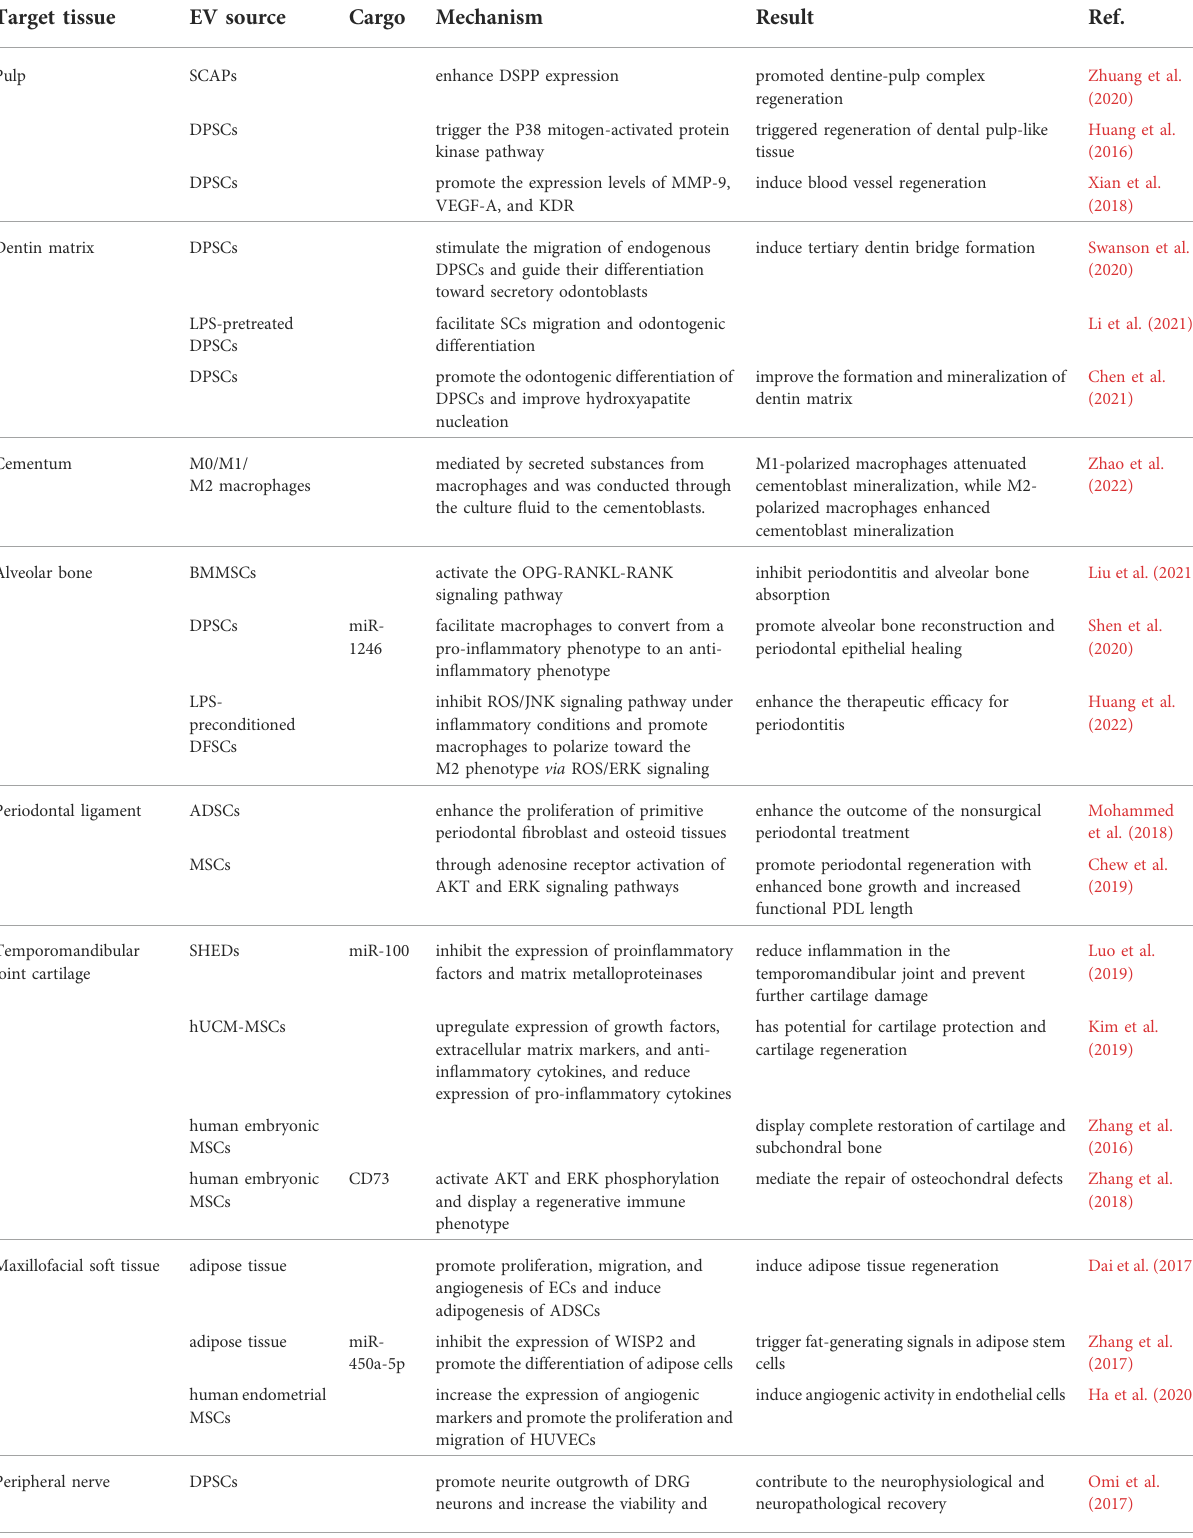
TABLE 1 Outlines of the effect of EVs in dental and maxillofacial tissue repair and regeneration